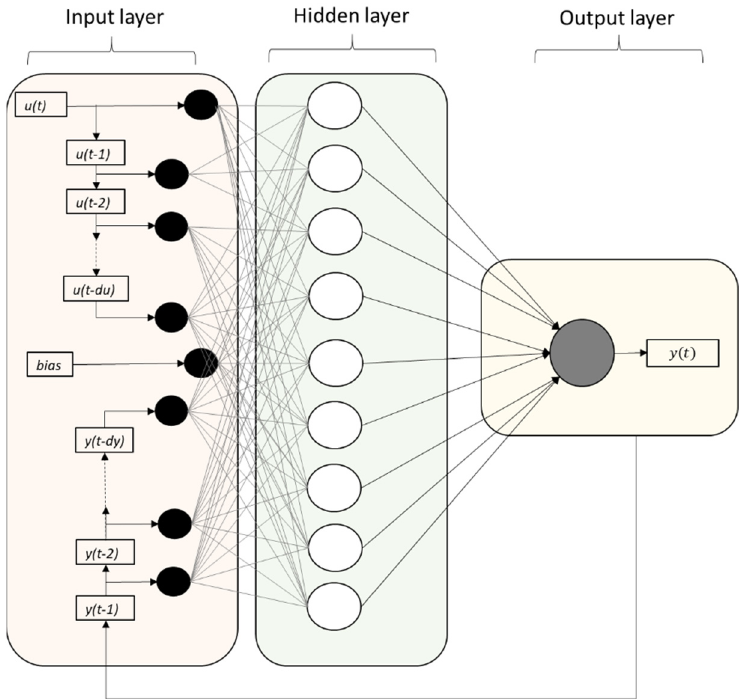
Figure 1. Graphical illustration of the NARX network with du input and dy output memory and a number of neurons in the hidden layer. Note that if the output memory is set at dy = 0, then the NARX network is reduced to a plain FTD neural network architecture.